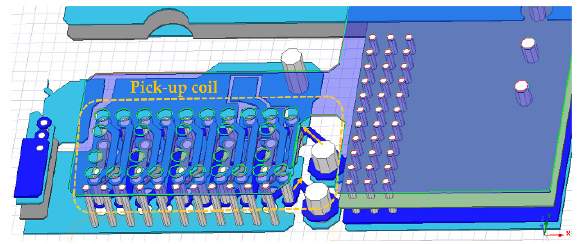
Figure 10. Q3D model of PCB with the proposed pick-up coil.